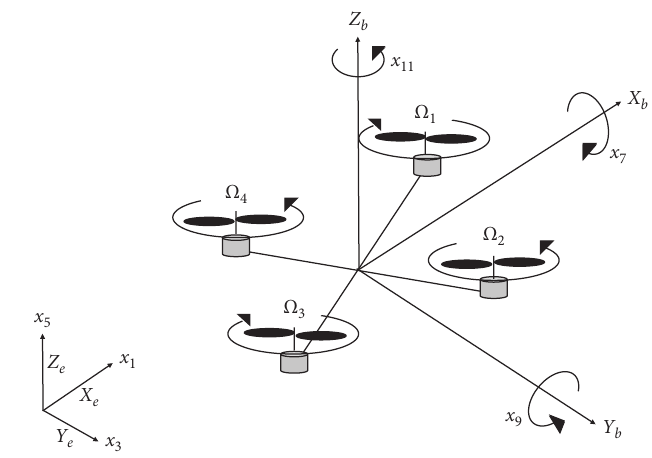
Figure 1: Quadrotor free-body